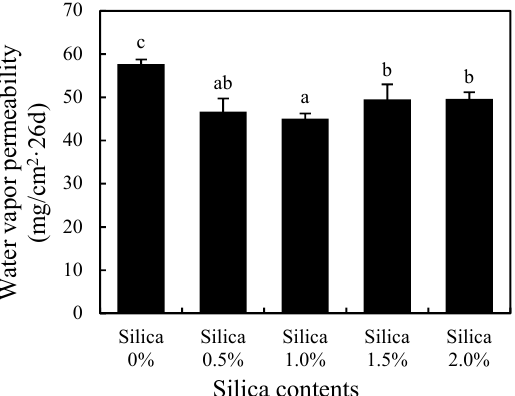
Figure 4. Water vapor permeability of pure polyacrylate film (silica 0 wt.%) and hybrid films with 0.5 wt.%, 1.0 wt.%, 1.5 wt.%, and 2.0 wt.% silica.